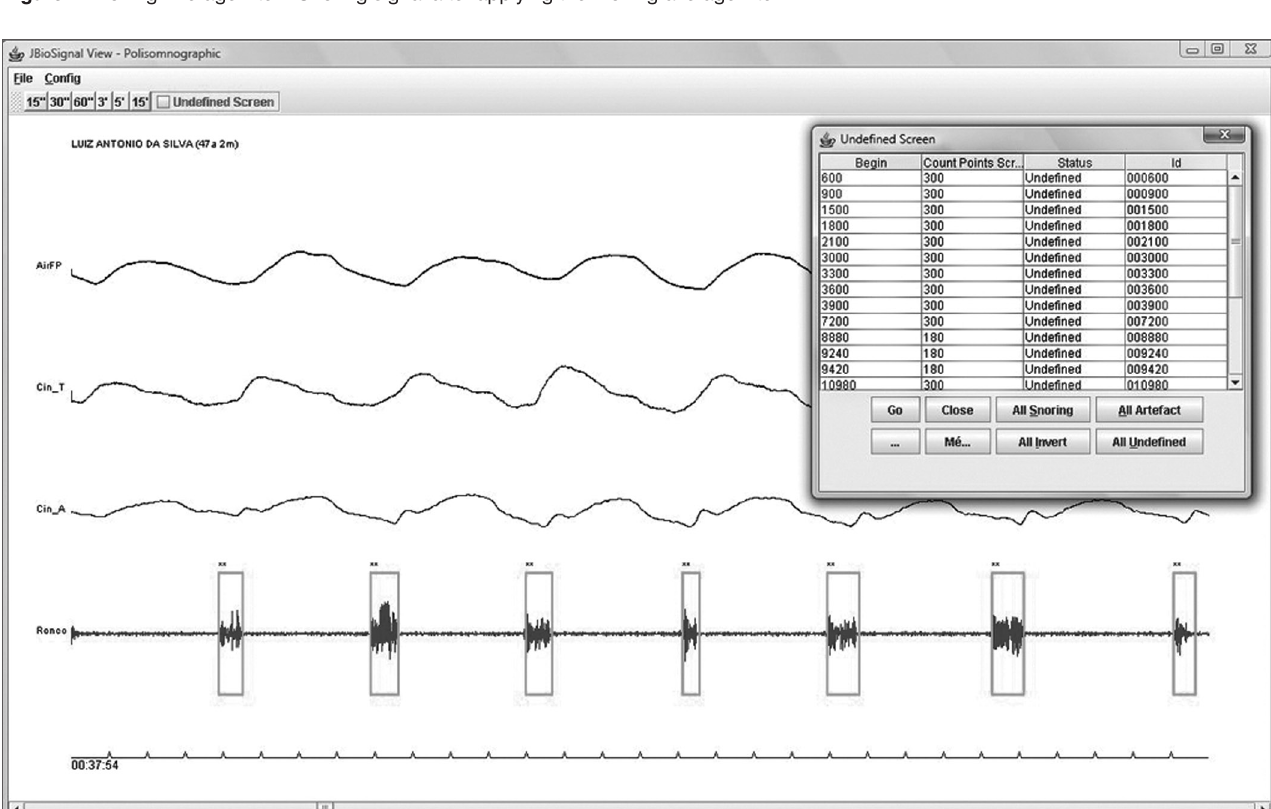
Figure 4. Moving-Average filter - Snoring signal after applying the moving-average filter.